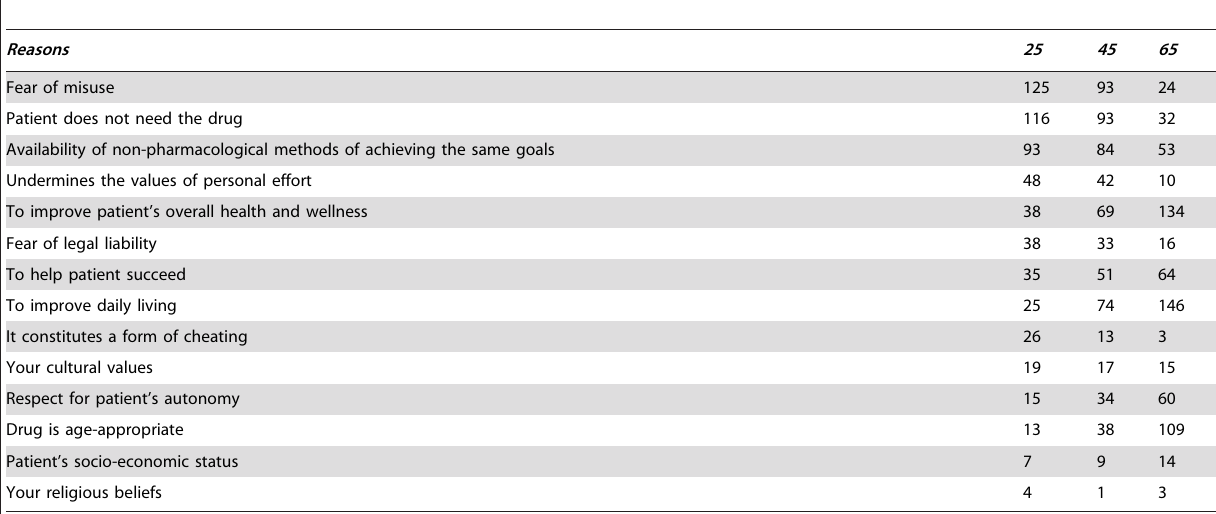
Table 2. Reasons Affecting Physician Comfort with Prescribing Cognitive Enhancers to Patients of Different Ages.